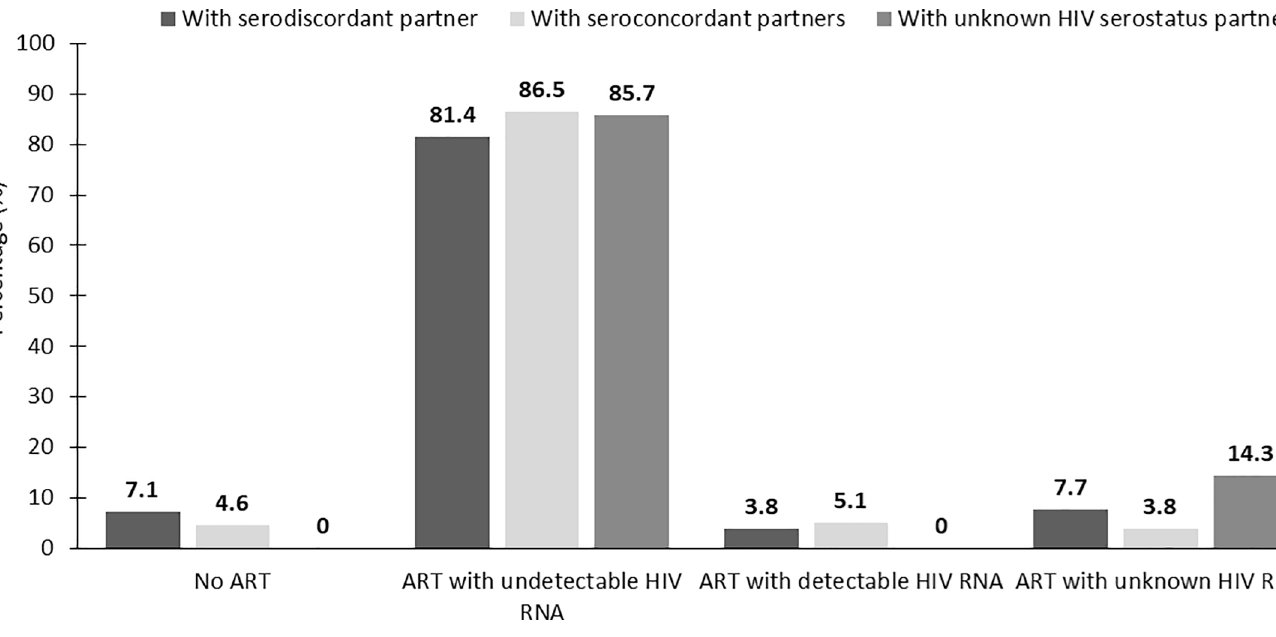
PLOS ONE | https://doi.org/10.1371/journal.pone.0198654 June 27,